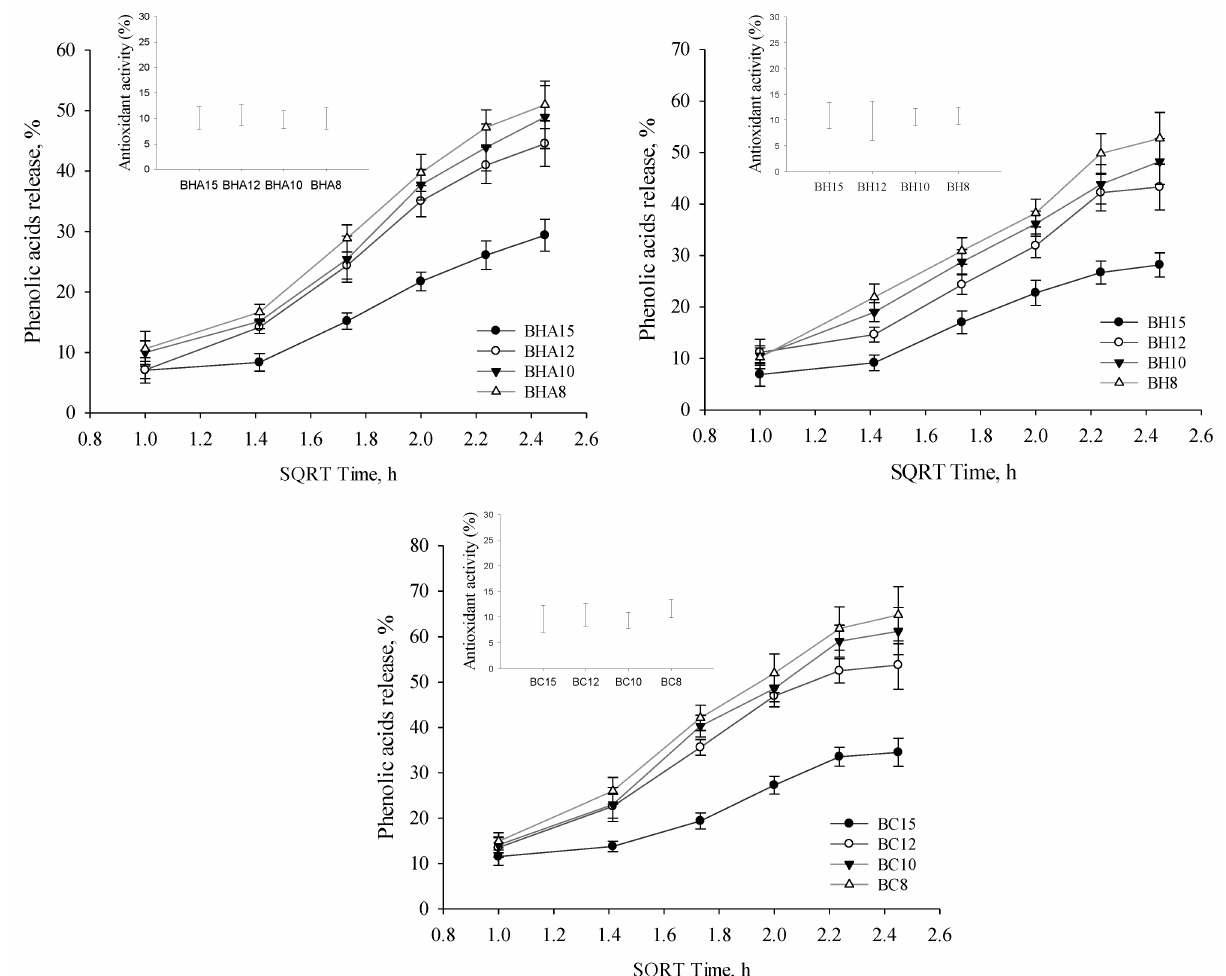
Figure 5. Percentage release of phenolic acids (sum of p -coumaric, cinnamic and caffeic acids) versus square root of time from all tested ophthalmic formulations.Subfigure shows antioxidant activity by ABTS method from the fractions collected during the release test after 6 h (mean ± SD, n =